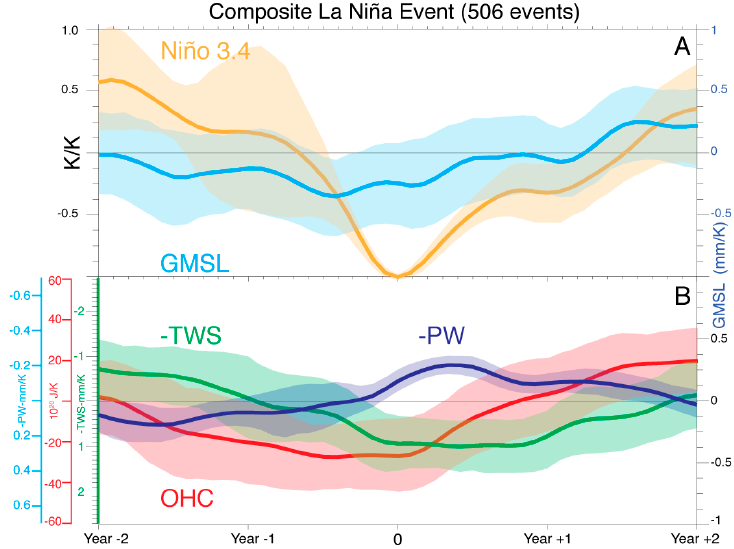
Figure 4. Summary of anomalies in: ( A ) La Niña event Niño3.4 temperature and GMSL; and ( B ) GMSL constituent terms including ocean heat content (OHC), terrestrial water storage (TWS) and precipitable water (PW). Shading indicates the σ range across ensemble members. A sign convention is used such that positive anomalies constitute an increase in GMSL.